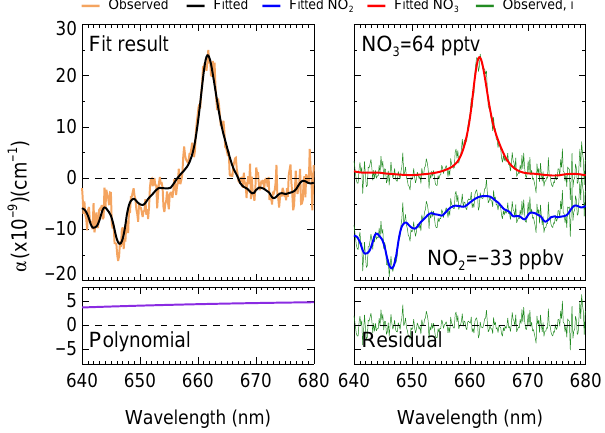
Figure 5. An example of the spectral fit for an extinction spectrum measured (5s average) during field measurements. The fitted results of NO 3 and NO 2 are shown as well as the third-order polynomial, the total fit result, and the residual.